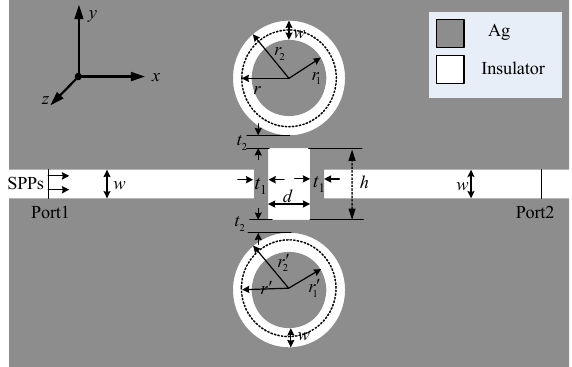
Fig. 1 2-dimensional (2D) schematic of the metal-insulator- metal waveguides coupled with rectangular and two shunt-wound rings